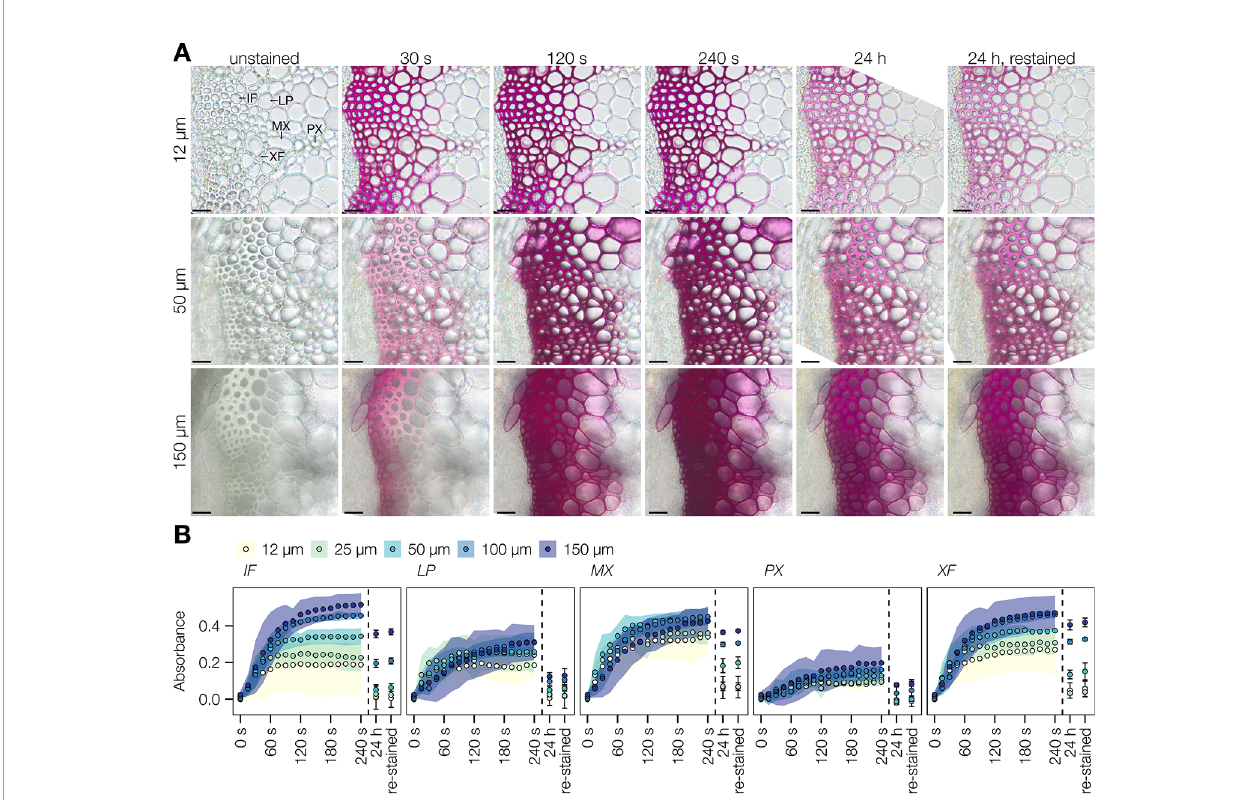
FIGURE 3 | Stability of the Wiesner test in plant sections. (A) Live imaging of Arabidopsis transverse stem sections before, during, and after staining with the Wiesner test. Different section thicknesses, ranging from 12 to 150 µm, were followed for 24 h, and re-stained with addition of new Wiesner test reagent. Ligni fi ed cell types include interfascicular fi bers (IF), ligni fi ed parenchyma (LP), metaxylem vessels (MX), protoxylem vessels (PX), and xylary fi bers (XF). Bars = 25 µm. (B) Changes in absorbance in response to the Wiesner test monitored by live imaging in the fi ve different cell types during the fi rst 240 s after staining, after 24 h, and after re-staining. Colored ribbons and bars indicate ± standard deviation. Measurements were done using 50 measurement points of 12 pixels each per cell type in fi ve independent